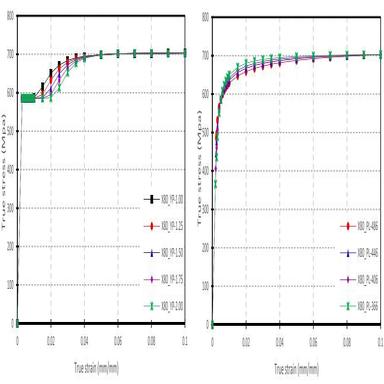
Idealized variations for stress-strain curves of X80-YPT and X80-RHT materials.